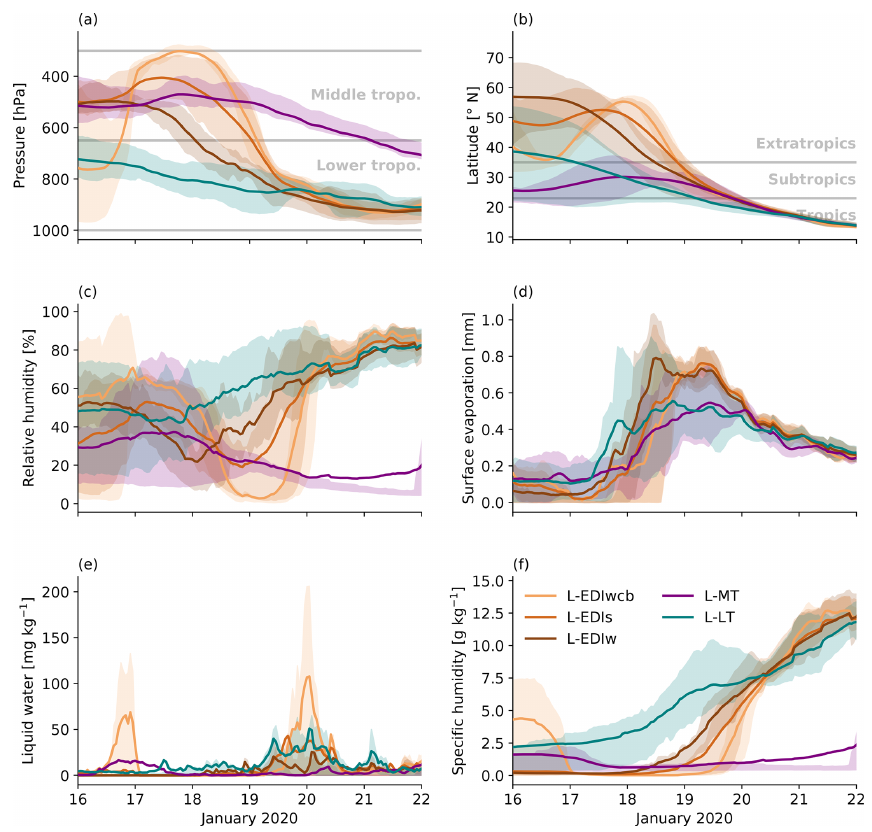
Figure 8. Time series along the five airstreams arriving at the BCO in the layer 1000–650hPa on 22 January 2020. The variables shown are (a) pressure, (b) latitude, (c) relative humidity, (d) surface evaporation, (e) liquid water content, and (f) specific humidity. Thick lines show mean values and the shading the 25th–75th percentile range. The number of trajectories assigned to each airstream is given in Table 1. Data: ERA5.